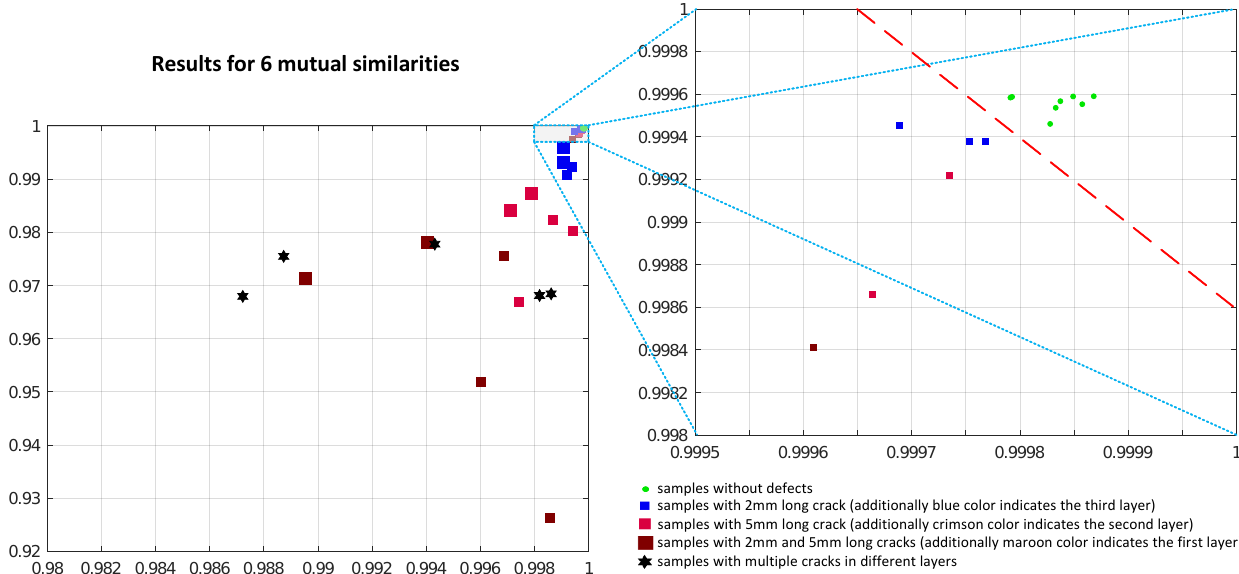
samples without defects samples with 2mm long crack (additionally blue color indicates the third layer) samples with 5mm long crack (additionally crimson color indicates the second layer) samples with 2mm and 5mm long cracks (additionally maroon color indicates the first layer) samples with multiple cracks in different layers Figure 22. Results obtained applying six mutual comparisons employing the SSIM4 metric using the maximum and average of its values calculated for 17 images corresponding to various frequencies used in experiments.